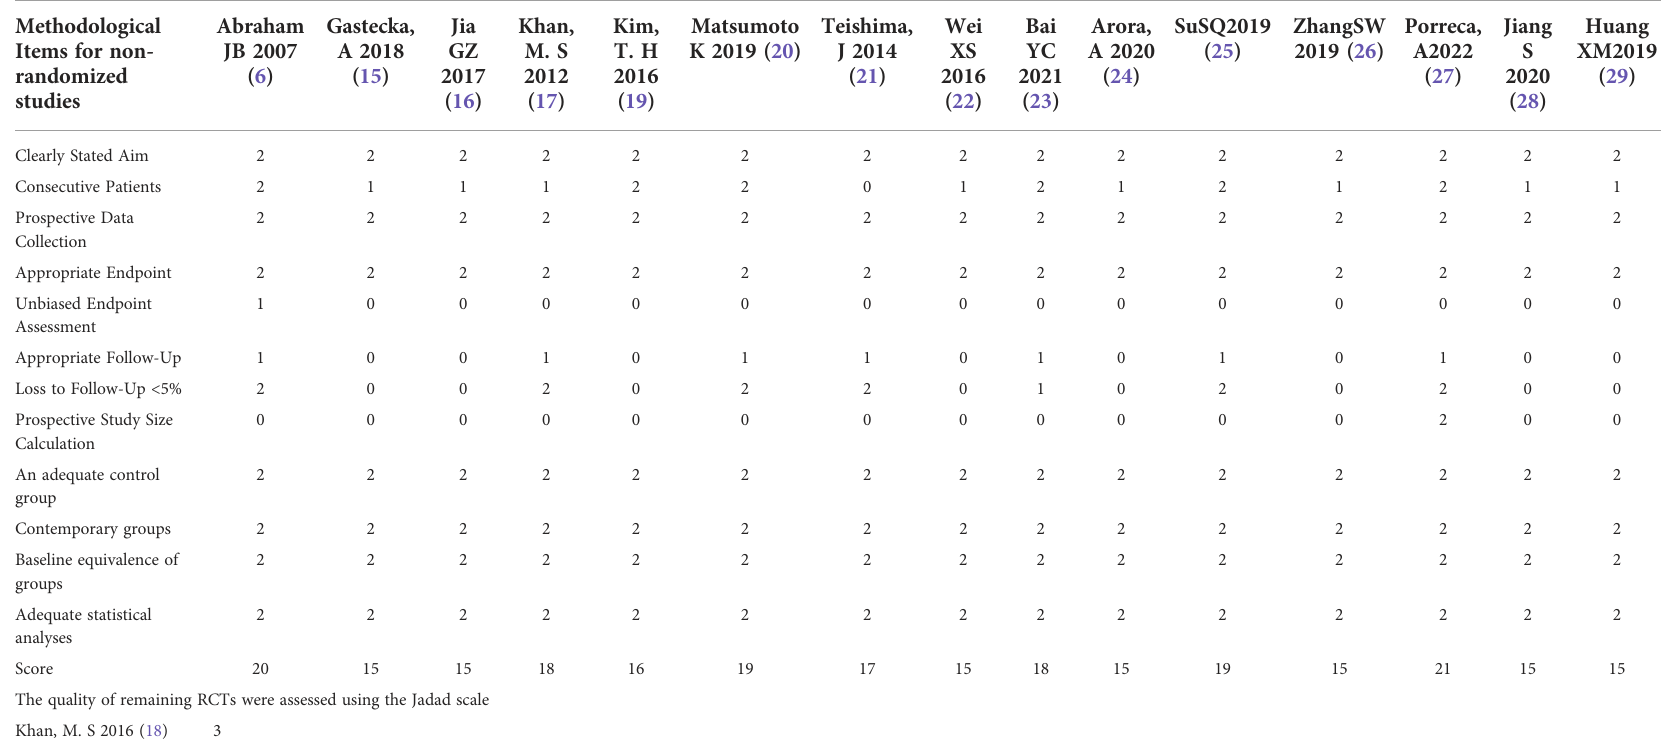
TABLE 2 Risk of bias for the involved studies. The quality of NRS was evaluated with the